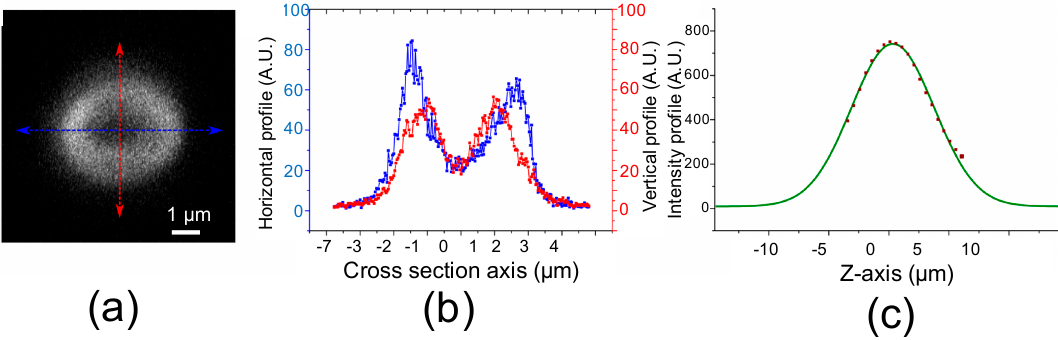
Figure 5. ( a ) Confocal top-view image of one single elliptically-shaped storage unit fabricated by using type A DLW. ( b ) Fluorescence intensity profile along the horizontal and vertical cross section at focal plane. ( c ) Fluorescence intensity profile and Gaussian fitting along the z -axis (depth).